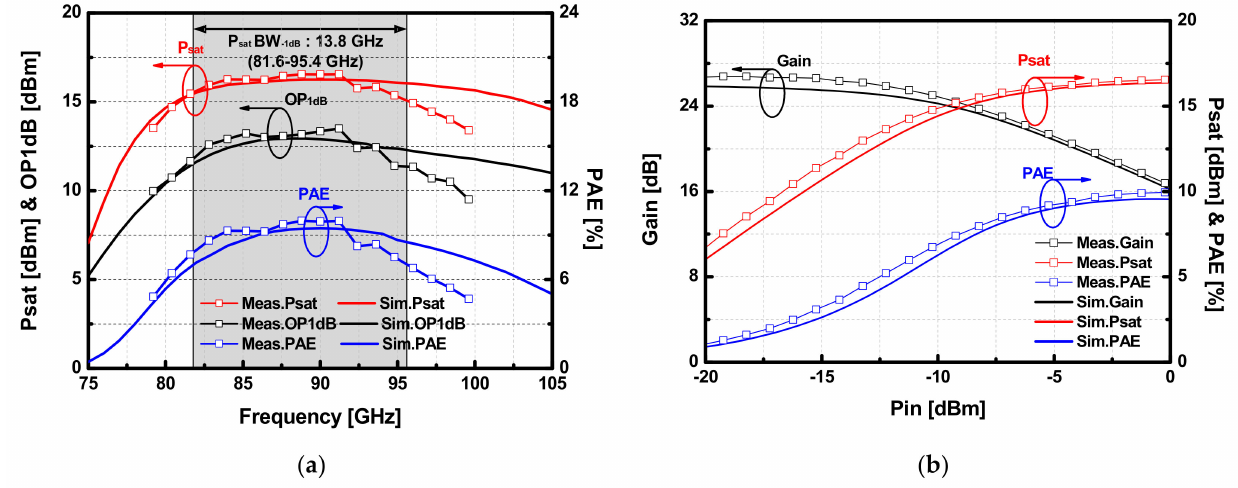
Figure 15. Results of the large-signal measurement of the W-band 8-way PA versus ( a ) frequency ( b ) input power at the center frequency (90